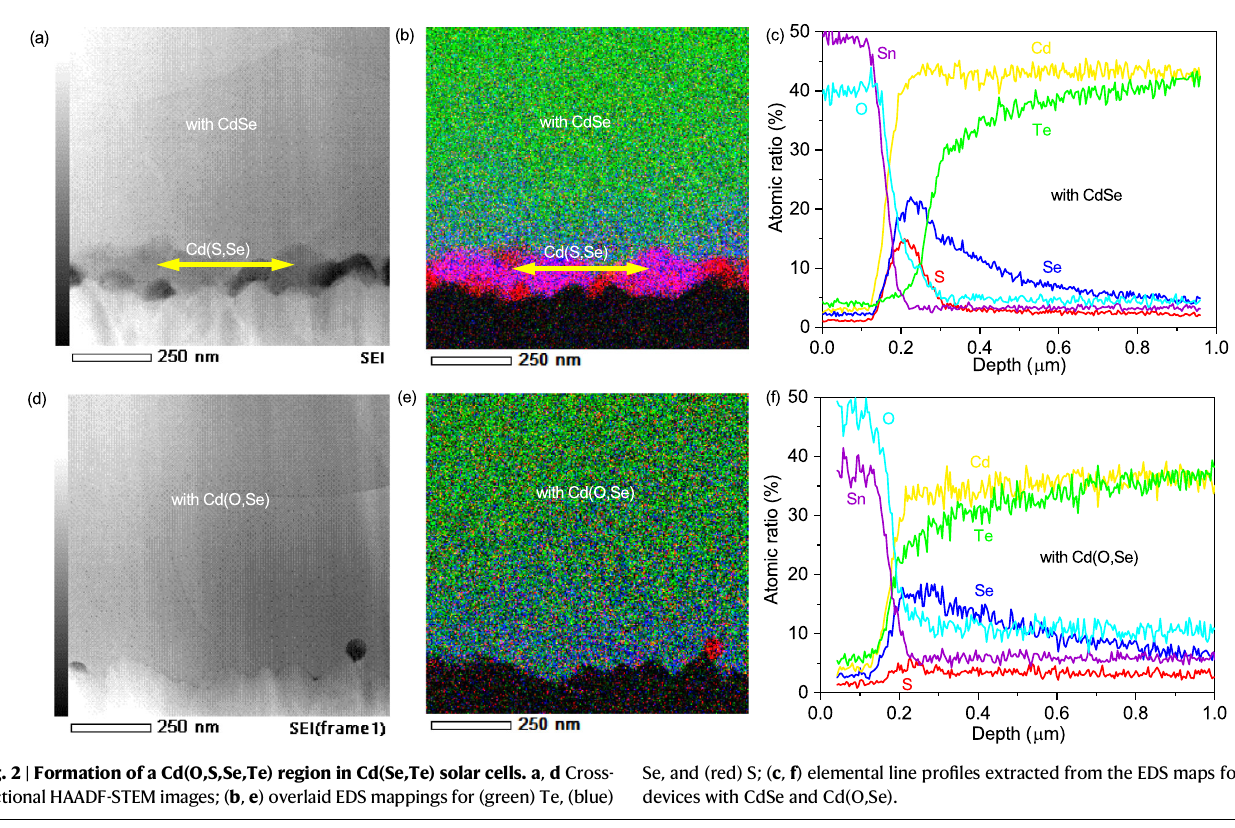
Se, and (red) S; ( c , f ) elemental line pro fi les extracted from the EDS maps for the devices with CdSe and